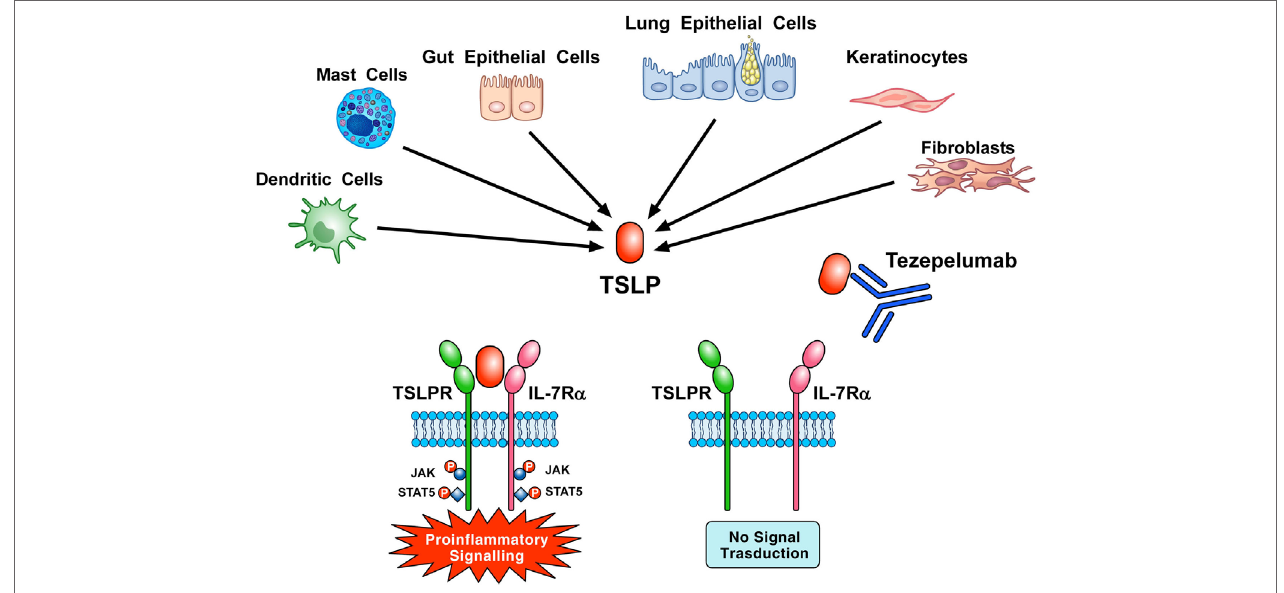
FiGURe 3 | Thymic stromal lymphopoietin (TSLP) produced mainly by gut and epithelial cells and keratinocytes but also by dendritic cells, mast cells, and fibroblasts initiates signaling by establishing a ternary complex with thymic stromal lymphopoietin receptor (TSLPR) and IL-7R α . Tezepelumab, a human mAb anti-TSLP, binds with high affinity to TSLP and blocks the formation of TSLPR:TSLP: IL-7R α ternary complex on effector cells. In particular, the variable heavy chain of tezepelumab binds to TSLP, while the variable light chain fragment does not interact with TSLP (44). Tezepelumab inhibits in vitro human DC maturation and chemokine production induced by TSLP (44) and reduced exacerbations and improved quality of life in patients with severe uncontrolled asthma